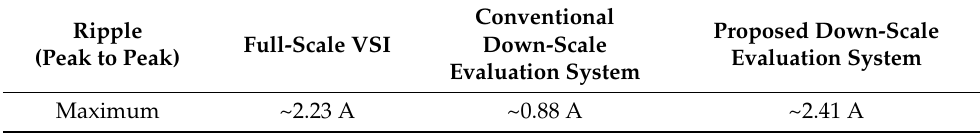
Table 4. Comparison of measured line-current ripple at maximum phase voltage.